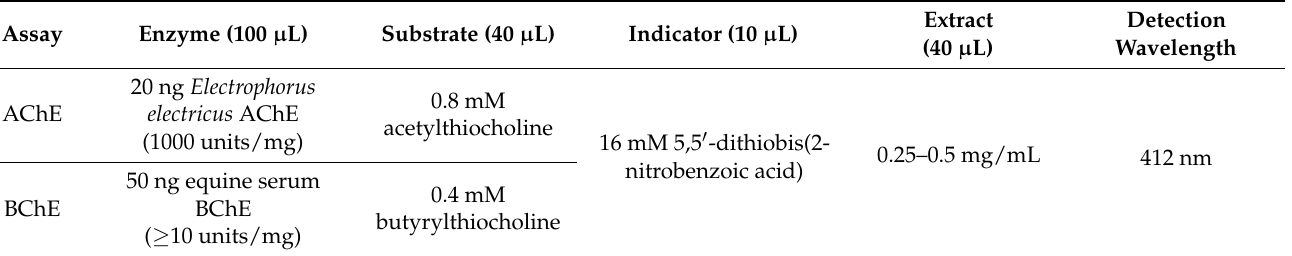
Table 3. Assay components for determination of acetylcholinesterase (AChE) and butyryl- cholinesterase (BChE) inhibitory